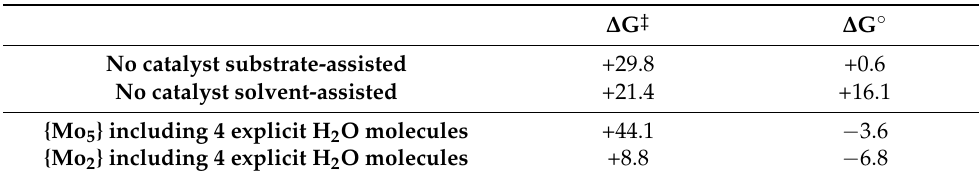
Table 4. Activation and equilibrium Gibbs free energies, ∆ G ‡ and ∆ G ◦ , in kcal mol − 1 , of the pNPP hydrolysis.